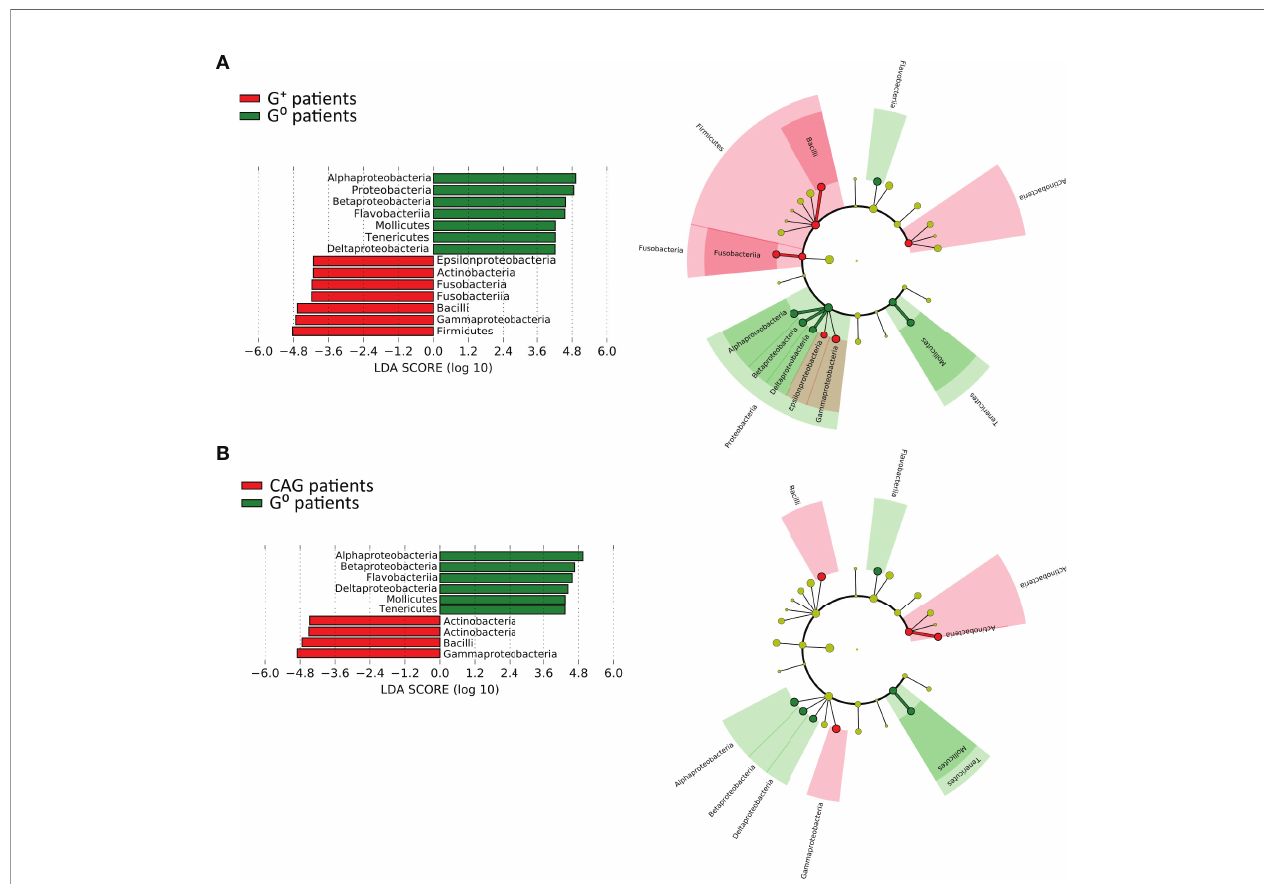
FIGURE 6 | Linear discriminant analysis with effect size measurement (LEfSe) of the duodenal microbiota between CAG or G + , and G 0 patients. LEfSe analysis in CAG (A) and G + patients (B) . On the left, histogram of the LDA scores computed for statistically signi fi cant differentially abundant taxa between the two groups. On the right, cladogram highlighting the relationship of signi fi cantly different taxa between G+ and G0 patients. Differences are represented in the color of the most abundant class, and each circle ’ s diameter is proportional to the taxon ’ s